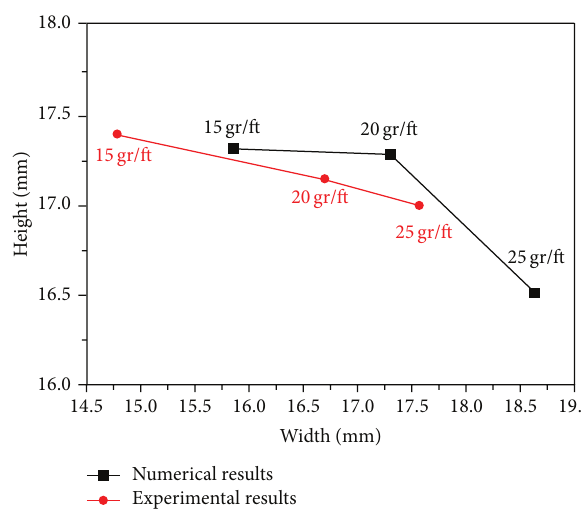
Figure 9: Comparison between the experimental and calculational